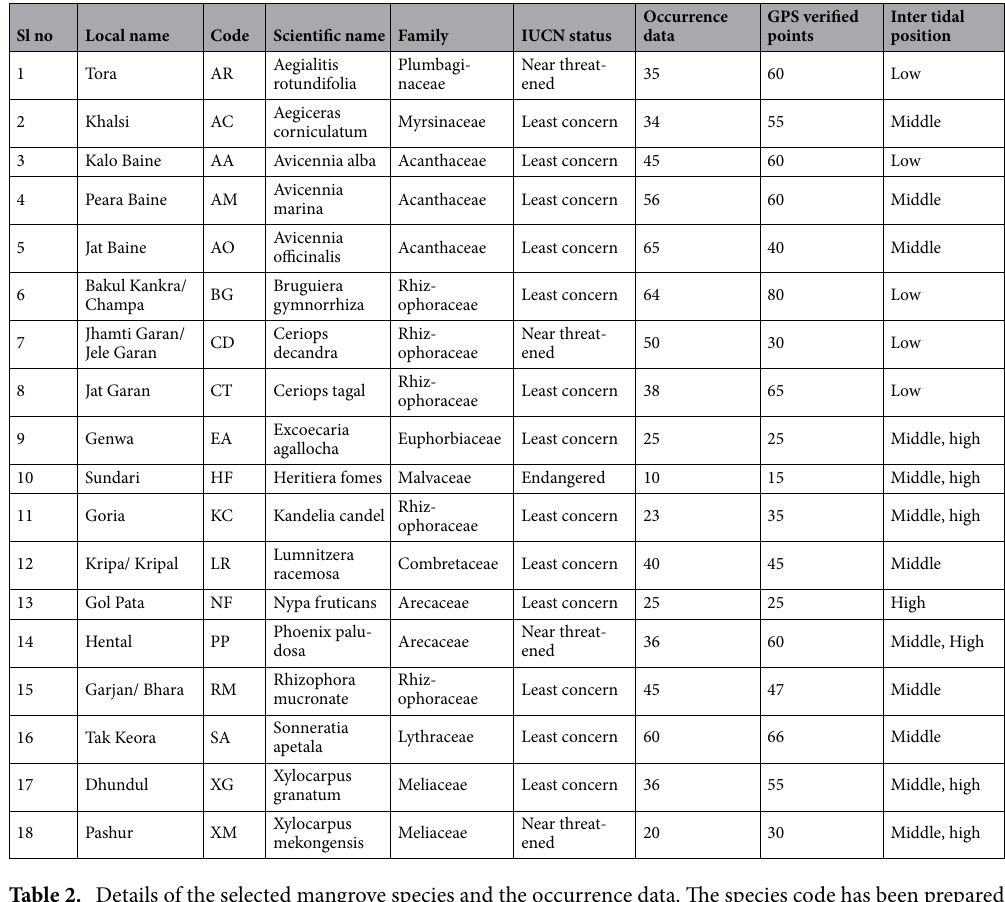
Table 2. Details of the selected mangrove species and the occurrence data. The species code has been prepared using the first letter of the species, hereafter this species code has been used throughout the manuscript. The species name and family name has been standardized through IUCN species list and the World Flora Online 75 . The species occurrence point data has been collected from different sources like the Global Biodiversity Information Facility (GBIF) database and literature. The GPS survey was carried out to collect the maximum possible occurrence data from the field. The information about the common local habitat of the selected species was confirmed through the local people and the literature.